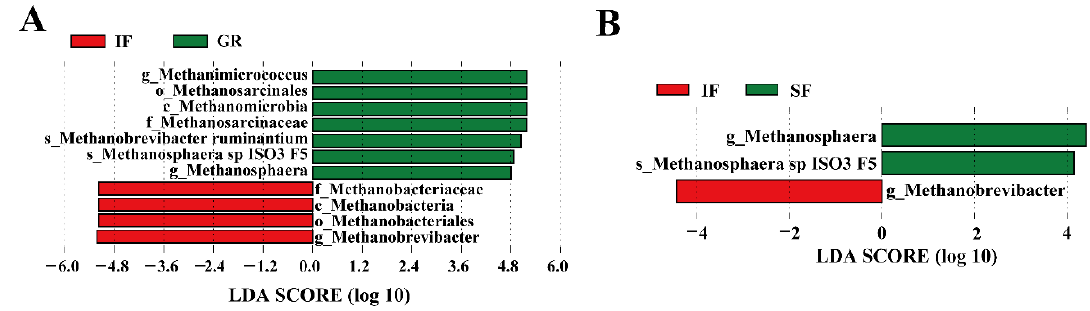
Figure 4. Archaeal taxa showing significantly di ff erent abundances in each of the three feeding systems based on pairwise comparisons using LEfSe (LDA score > 4 and p < 0.05). ( A ) Archaeal biomarkers identified in the pairwise comparison between GR and IF; ( B ) archaeal biomarkers identified in the pairwise comparison between SF and IF. Animals 2020 , 10 , x